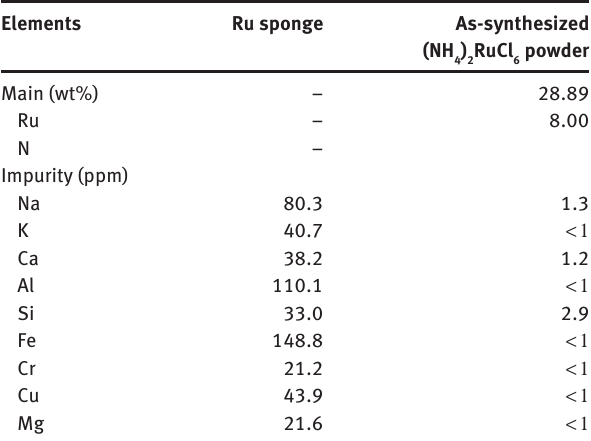
) RuCl powder. 4 2 6